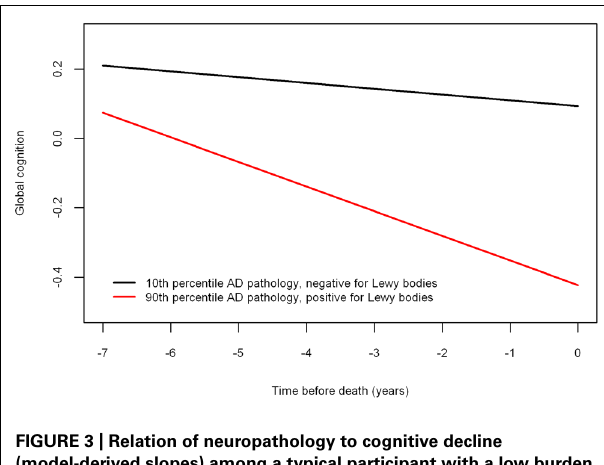
FIGURE 3 | Relation of neuropathology to cognitive decline (model-derived slopes) among a typical participant with a low burden of pathology (10th percentile amyloid = 0 and tangles = 0.311 and negative for neocortical LBD) versus a participant with a high burden of pathology (90th percentile amyloid = 9.262 and tangles = 8.048 and positive for neocortical LBD).